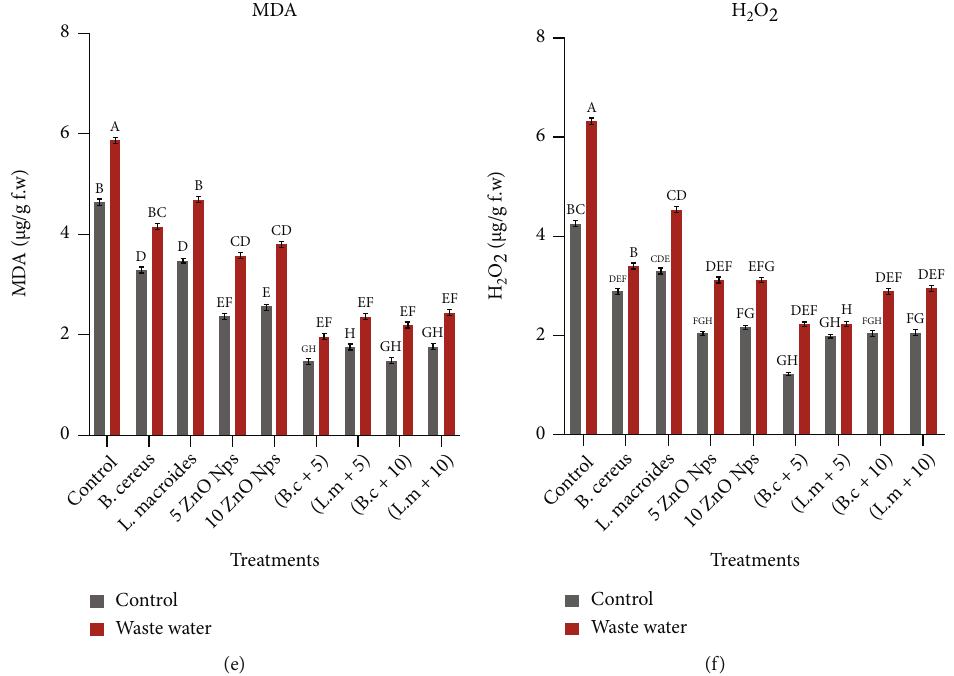
Figure 5: Synergistic e ff ect of bacteria strains ( Bacillus cereus and Lysinibacillus macroides ) and ZnO NP (5 mg/L and 10 mg/L) treatments on (a) superoxide dismutase, (b) peroxidase, (c) catalase, (d) ascorbate peroxidase, (e) malondialdehyde, and (f) hydrogen peroxide on rice grown in heavy metal-contaminated water. Error bars showed means of standard error ( ± SE) of three replicates ( n = 3 ) followed by di ff erent alphabetic letters showing statistical signi fi cance at 5% probability level. Control (distilled water), B.C+5 ( Bacillus cereus +5mg/L ZnO NPs), L.M+5 ( Lysinibacillus macroides +5 mg/L ZnO NPs), B.C+10 ( Bacillus cereus +10mg/L ZnO NPs), and L.M+10 ( Lysinibacillus macroides +10mg/L ZnO